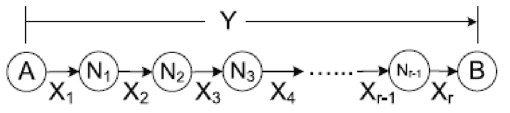
Figure 4. Opportunity path